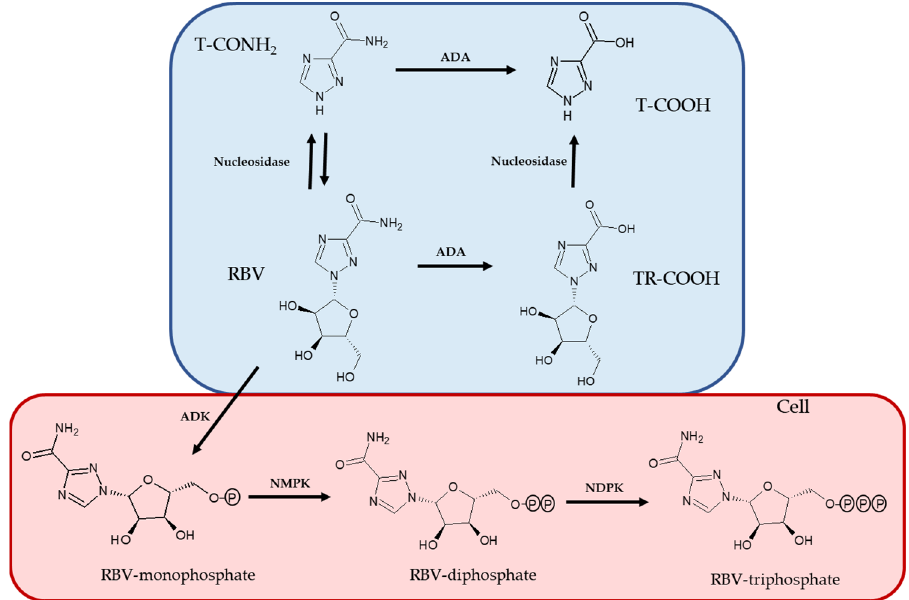
Figure 7. RBV metabolic pathway. Blue: extracellular compartment; red: intracellular compartment. ADA: adenosine deaminase; ADK: adenosine kinase; NMPK: nucleoside monophosphate kinase; NDPK: nucleoside diphosphate kinase.